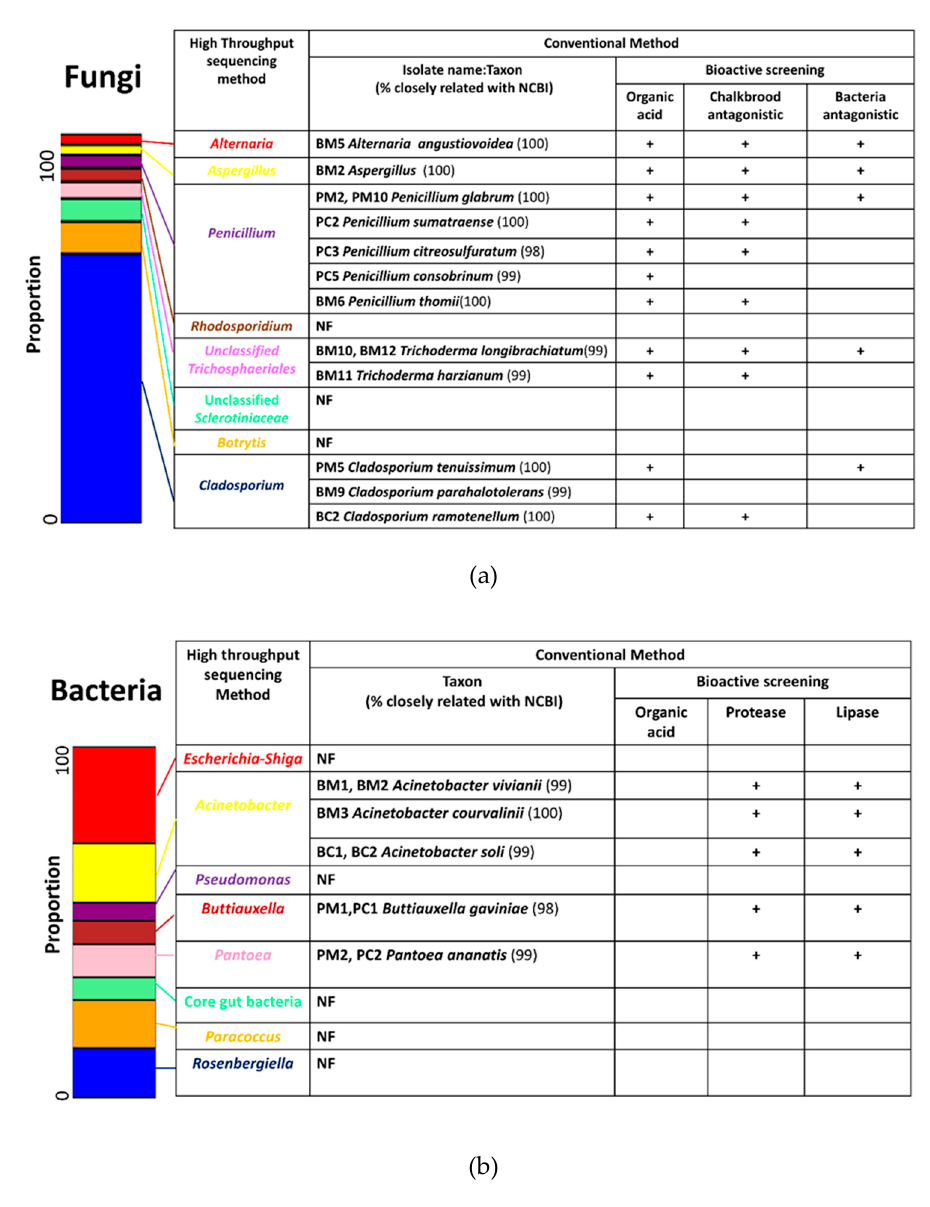
Figure 4. Combined results of high-throughput sequencing with conventional methods for bacterial ( a ) and fungal communities ( b ).